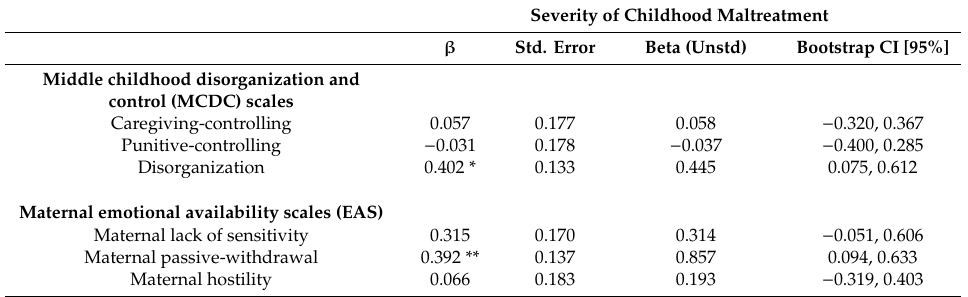
Table 3. Regression results for associations between mother–child interactions during middle childhood and severity of childhood maltreatment by age 18. Severity of Childhood Maltreatment β Std. Error Beta (Unstd) Bootstrap CI